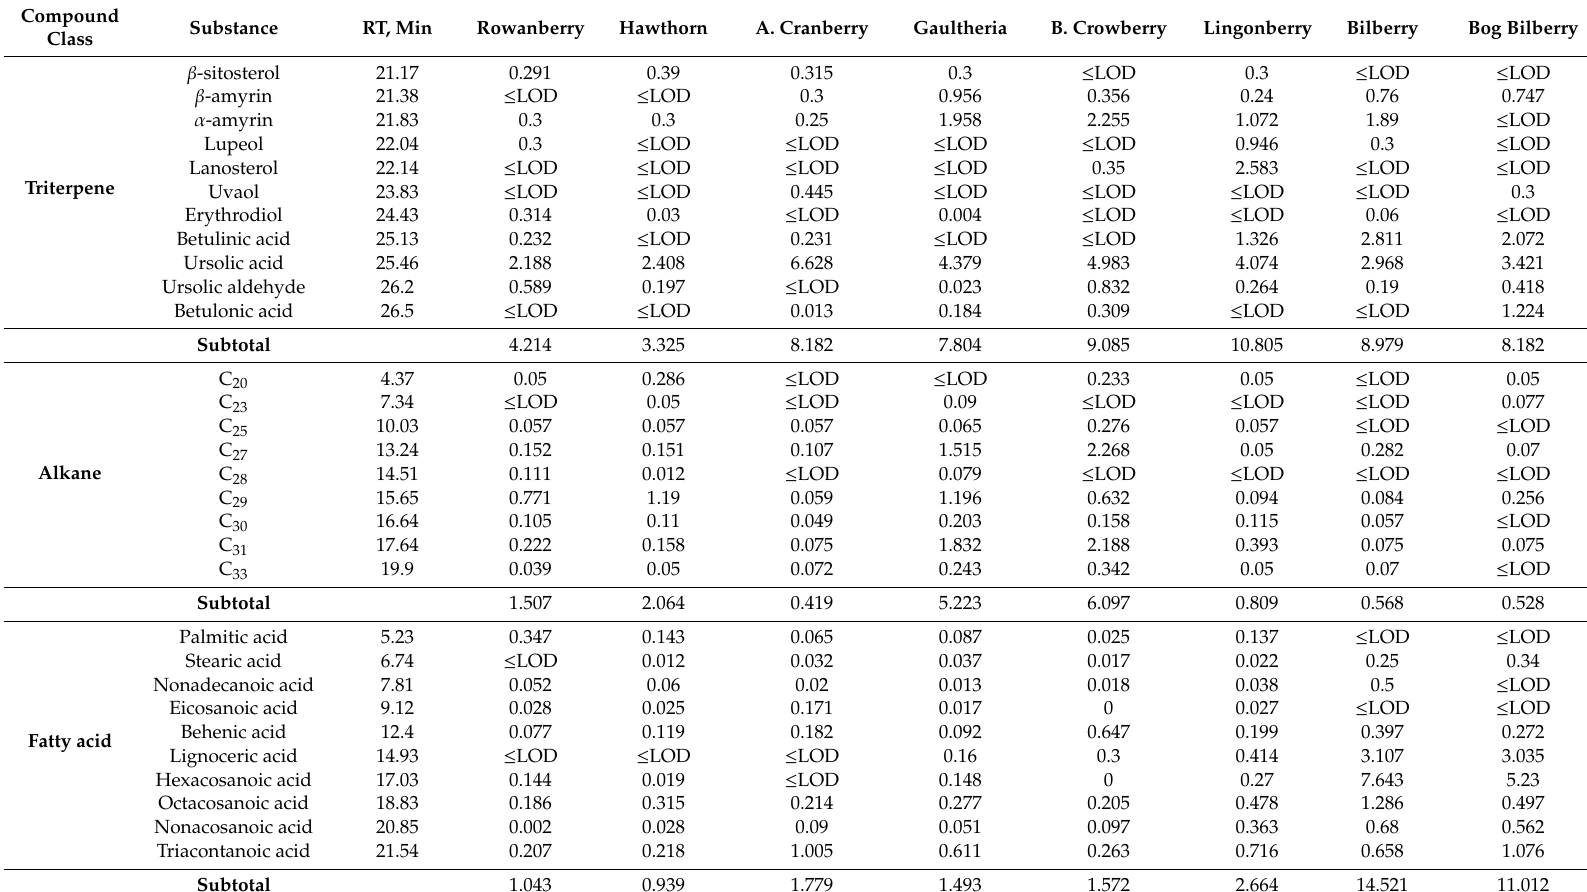
Table A1. Identified compounds found as part of cuticular wax of studied wild berries. ≤ LOD—concentration of substance was less than the limit of detection. Concentration of each substance expressed as g 100 g − 1 of berry cuticular wax extract. Standard error of measurements was determined to be 3–6% ( n =